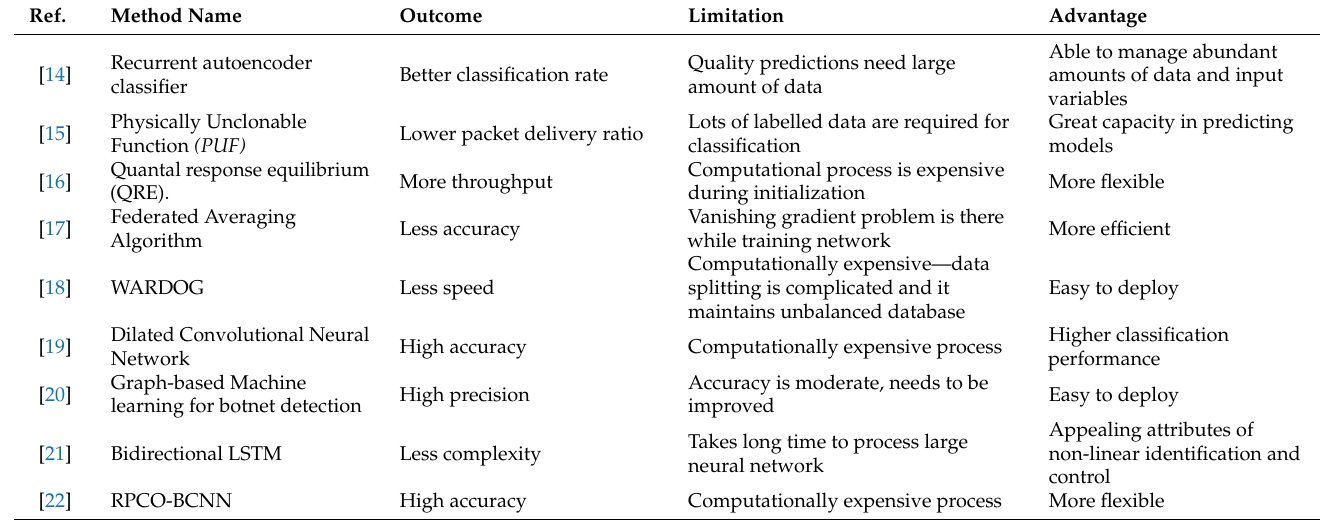
Table 1. Summary and limitations of some existing studies.